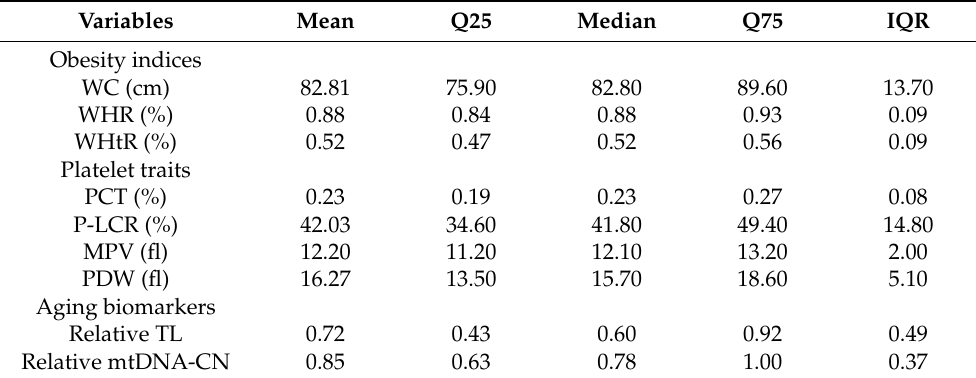
Table 2. Distributions of obesity indices, platelet traits, and aging biomarkers.